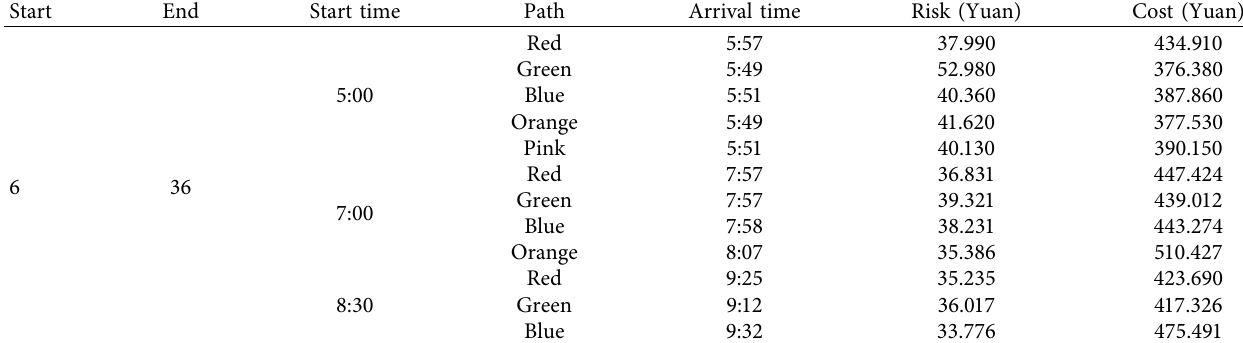
Table 7: Pareto nondominated solutions between nodes with different starting times.